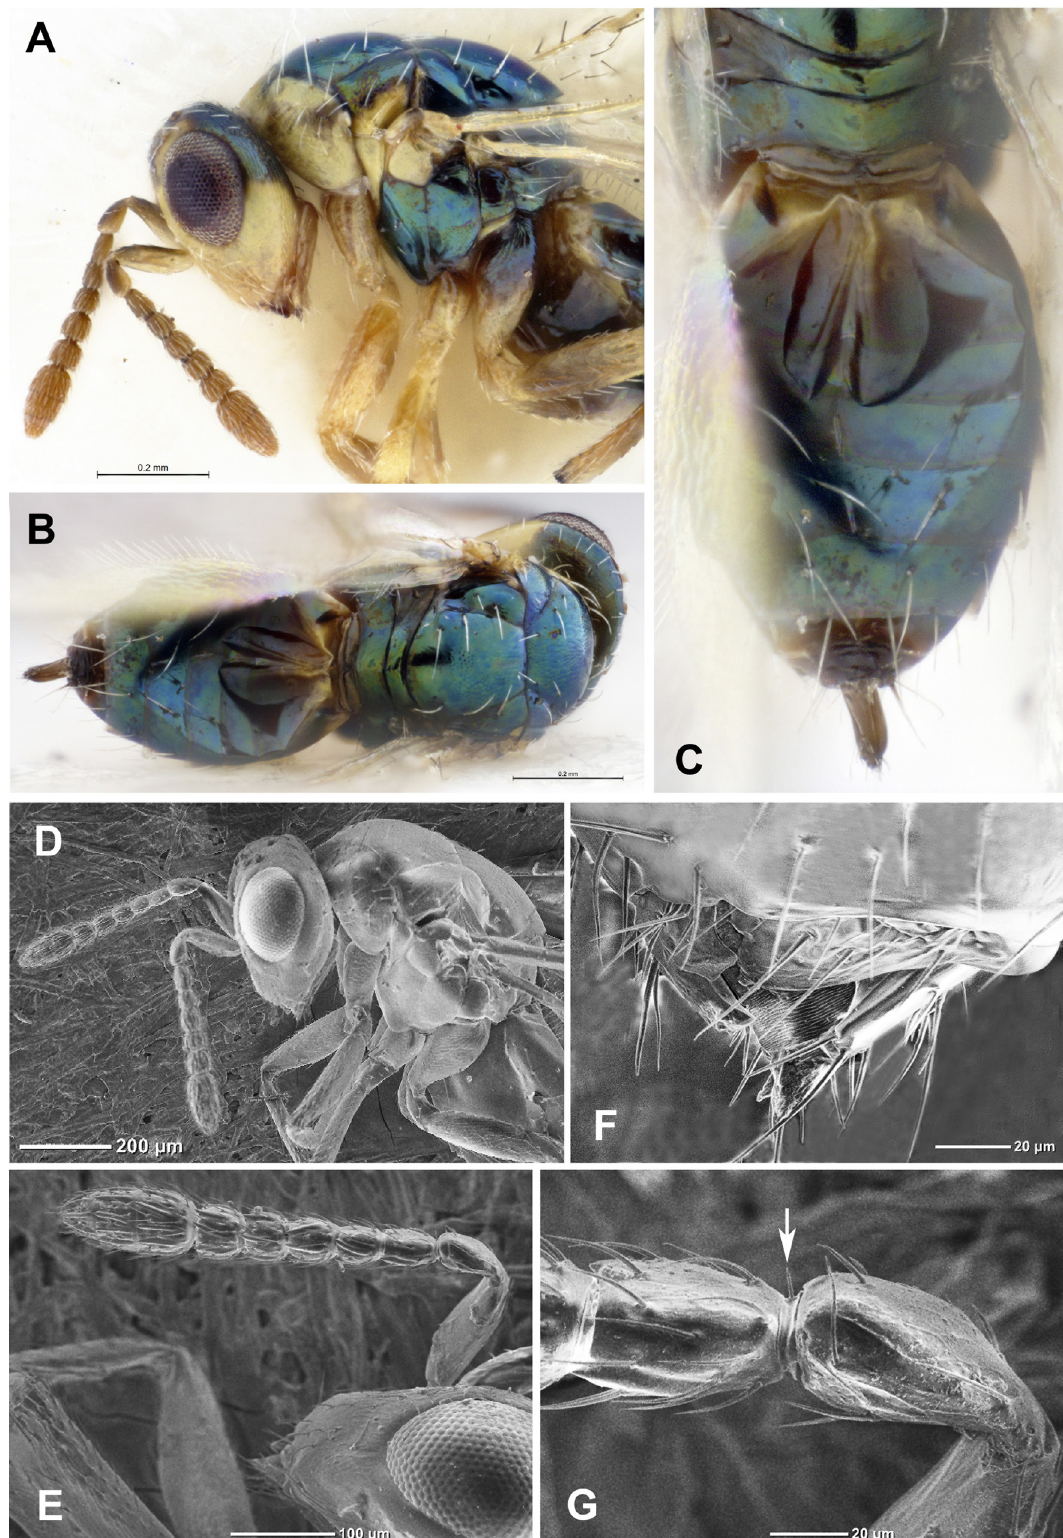
Fig. 3. Afrocampe prinslooi gen. et sp. nov., holotype, ♀. A , D . Head and mesosoma in lateral view. B . Body in dorsal view. C . Metasoma and posterior part of mesosoma. E . Antenna. F . Mouth opening and clypeus. G . Pedicel, anellus and F1 (seta on anellus is arrowed). A–C = color imaging; D–G =